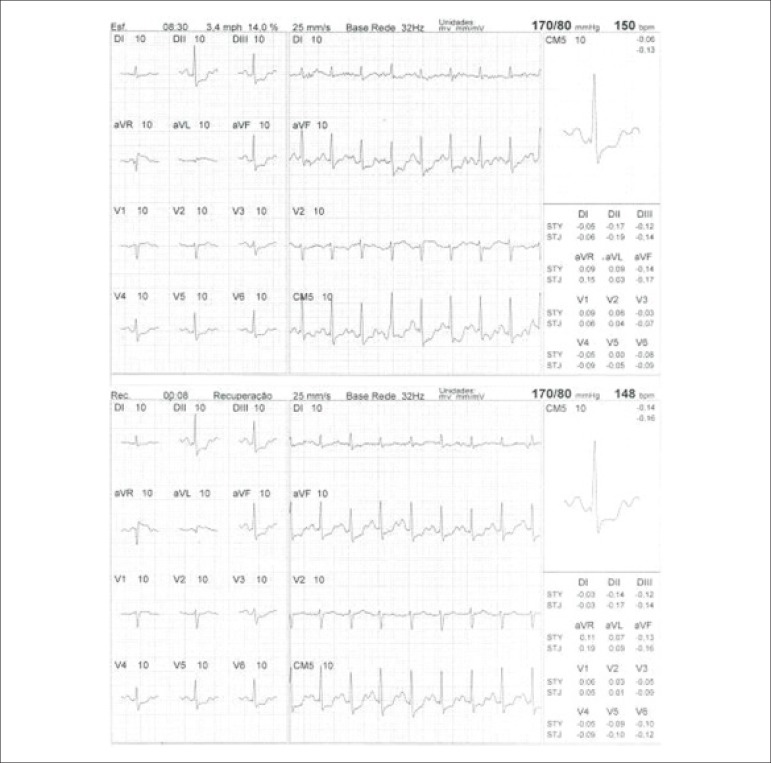
Case 1 - Electrocardiogram tracing during peak stress and initial recovery with alterations (explained in the text).